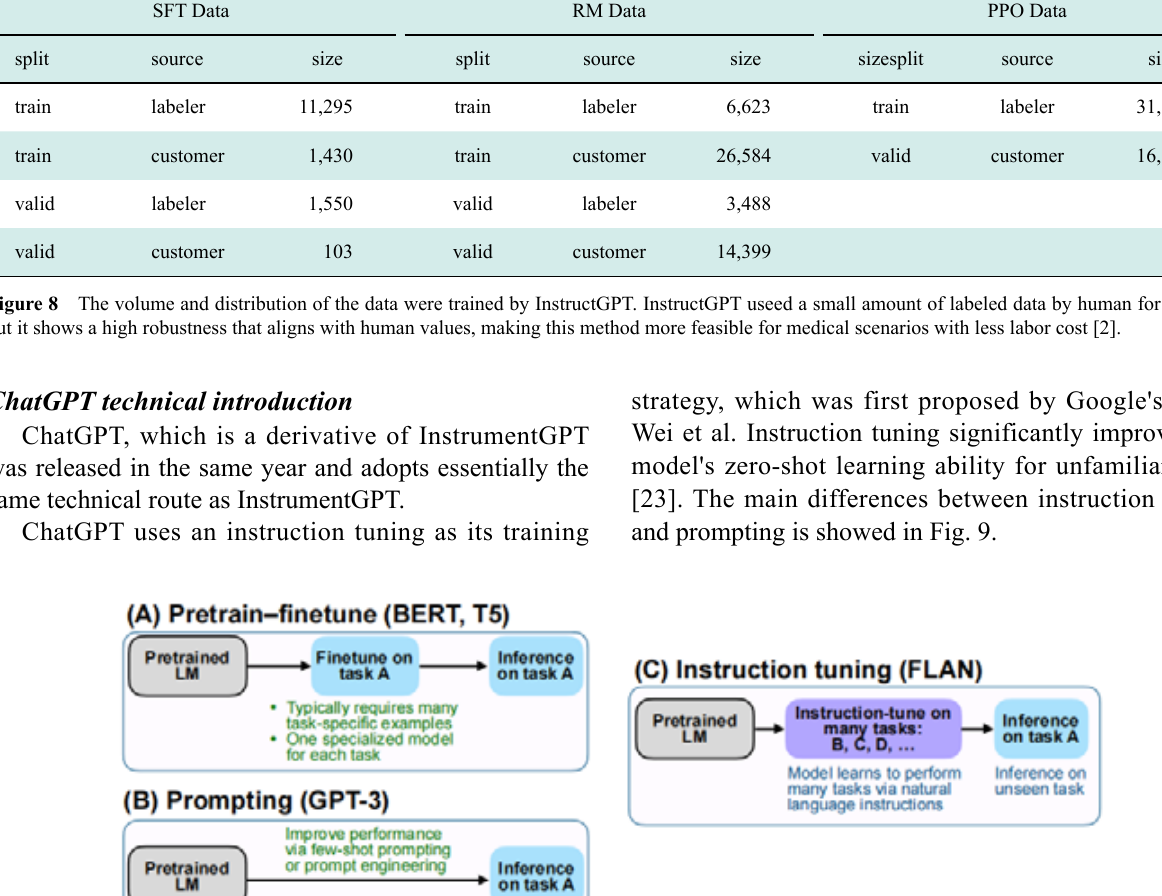
Figure 9 Comparison of pretraining fine tuning, prompting, and instruction tuning. Prompting and instruction tuning differ in how they activate the language models' abilities. Prompting triggers the completion ability of the models by needing few samples to fine-tune them for a downstream task. However, instruction tuning triggers the understanding ability of the language models and enables them to learn from the multiple downstream tasks. The model can follow more explicit instructions from users without fine-tuning on few samples, which improves their generalization ability across various tasks [23].